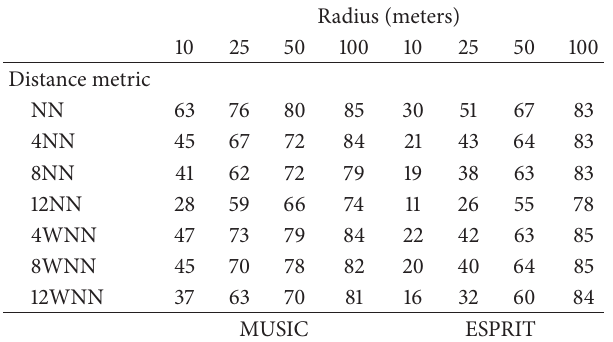
Table 4: Number of “hits” within given radius to actual location Table 2: Number of “hits” within given radius to actual location for each distance metric out of 100 trials. SNR = 30 dB; number for each distance metric out of 100 trials. SNR = 15dB; number of of antennas = 8; oversampling factor = 2; distance-threshold = 0.2, antennas = 8; oversampling factor = 2; distance-threshold = 0.2, Scenario Scenario A. Radius (meters)